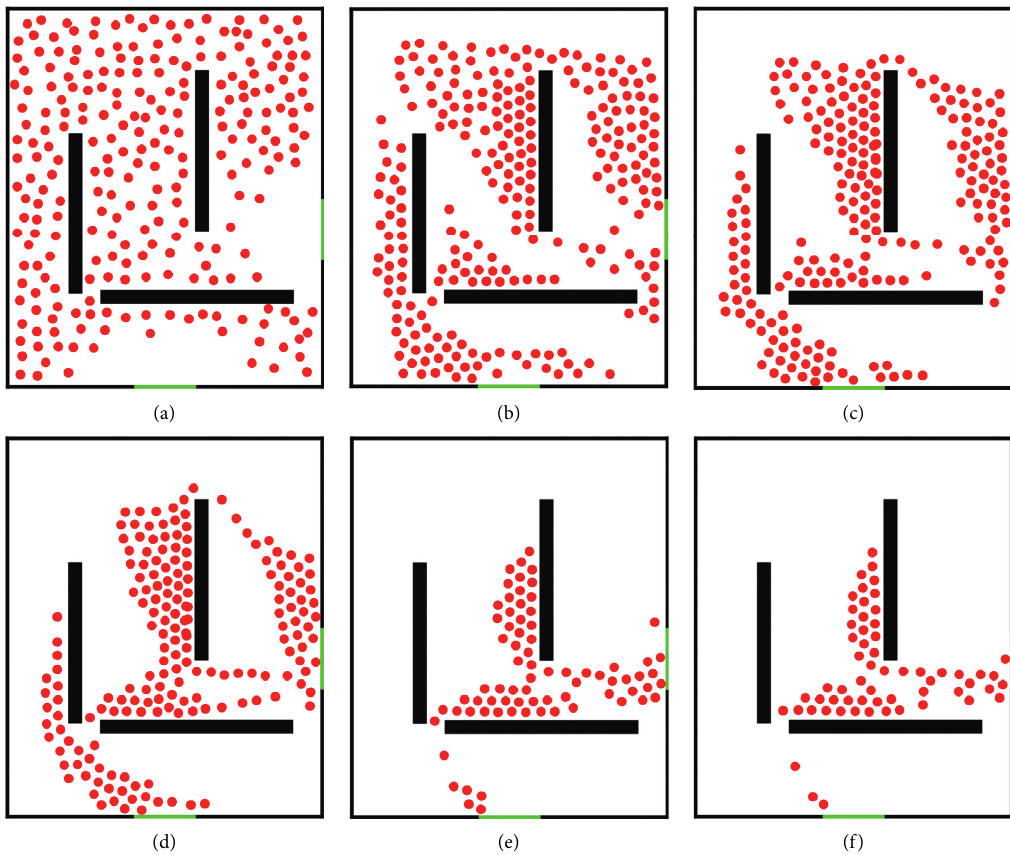
Figure 2: Simulation process. (a) t � 1 s. (b) t � 7s. (c) t � 11s. (d) t � 15 s. (e) t � 19s. (f) t � 22s.